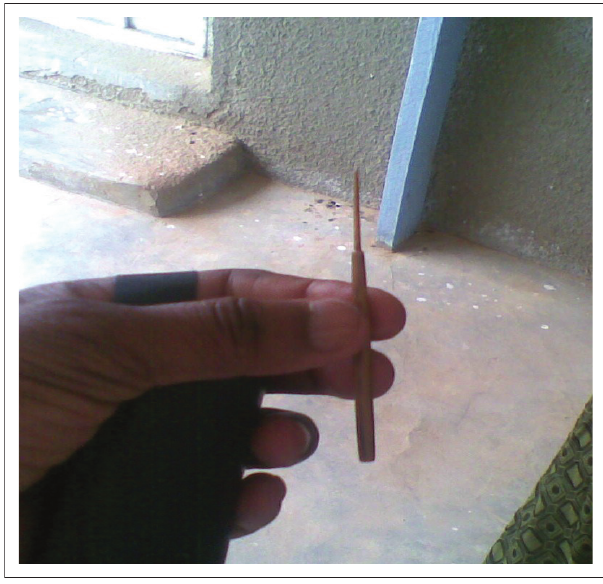
FIGURE 3: Pointed instrument used to perform TABLE 2: Responses of five couchers to images of common eye conditions. Eye condition shown in the Number who correctly Treatment couchers photograph identified the condition recommended Trachomatous trichiasis 5